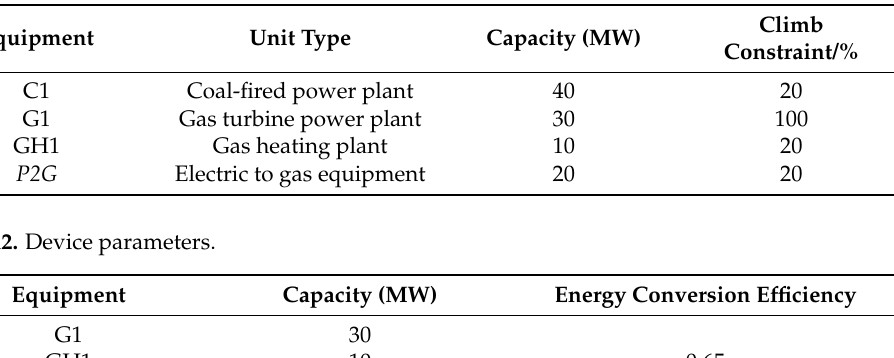
Table A1. Generator parameters.